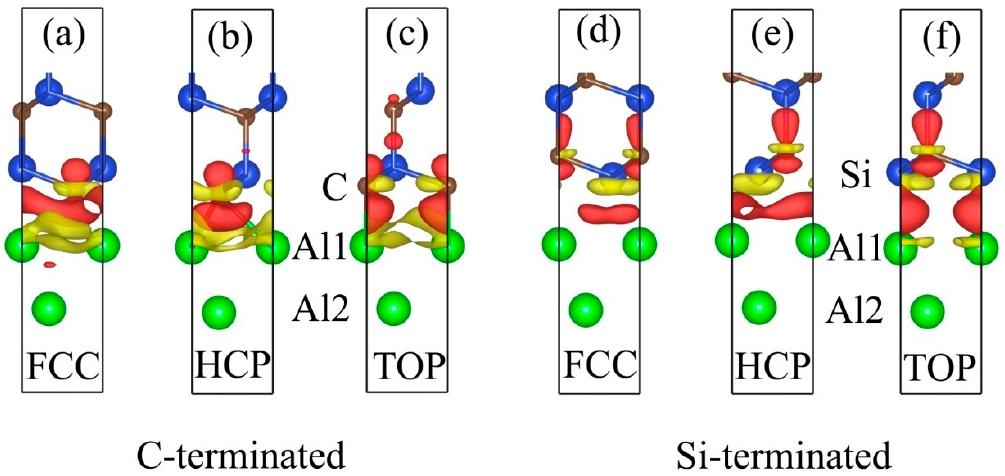
Figure 2. Charge density difference of the Al (111) / 6H-SiC (0001) interfaces. Red and yellow denote charge enrichment and deficiency, respectively. There are three stacking sequence at the Al (111) / 6H-SiC (0001) interface, including the FCC site ( a , d ), HCP site ( b , e ) and TOP site ( c , f ). Al, C, Si and H atoms are expressed by green, brown, blue and black solid spheres, respectively.